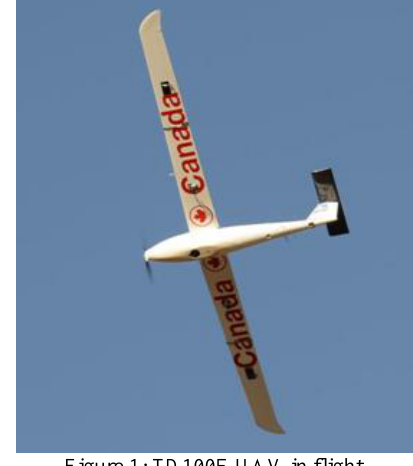
Figure 1: TD100E UAV in flight